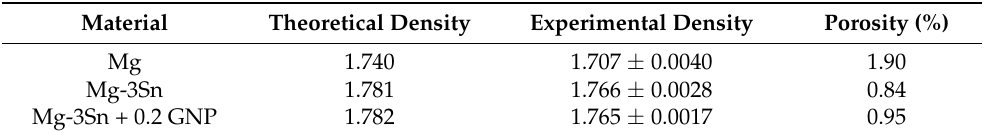
Table 1. Density (g/cc) measurements of pure Mg, Mg-3Sn alloy, and Mg-3Sn + 0.2 GNP nanocom- posite.